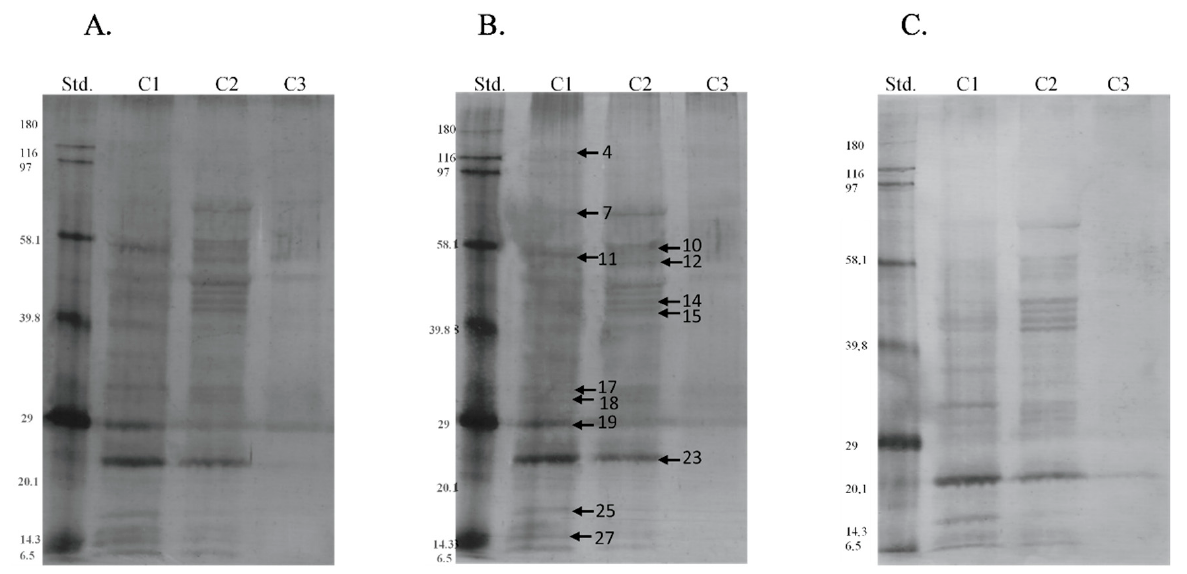
Figure 6. Western blot analysis of phosphoserine ( A ), phosphothreonine ( B ), and phosphotyrosine ( C ) residues obtained from sperm extracts during the breeding season. Std.—Biotinylated Molecular Weight Protein Standards (Sigma-Aldrich). C1—caput, C2—corpus, C3—cauda. Phosphoproteins identified by mass spectrometry are marked with arrows.